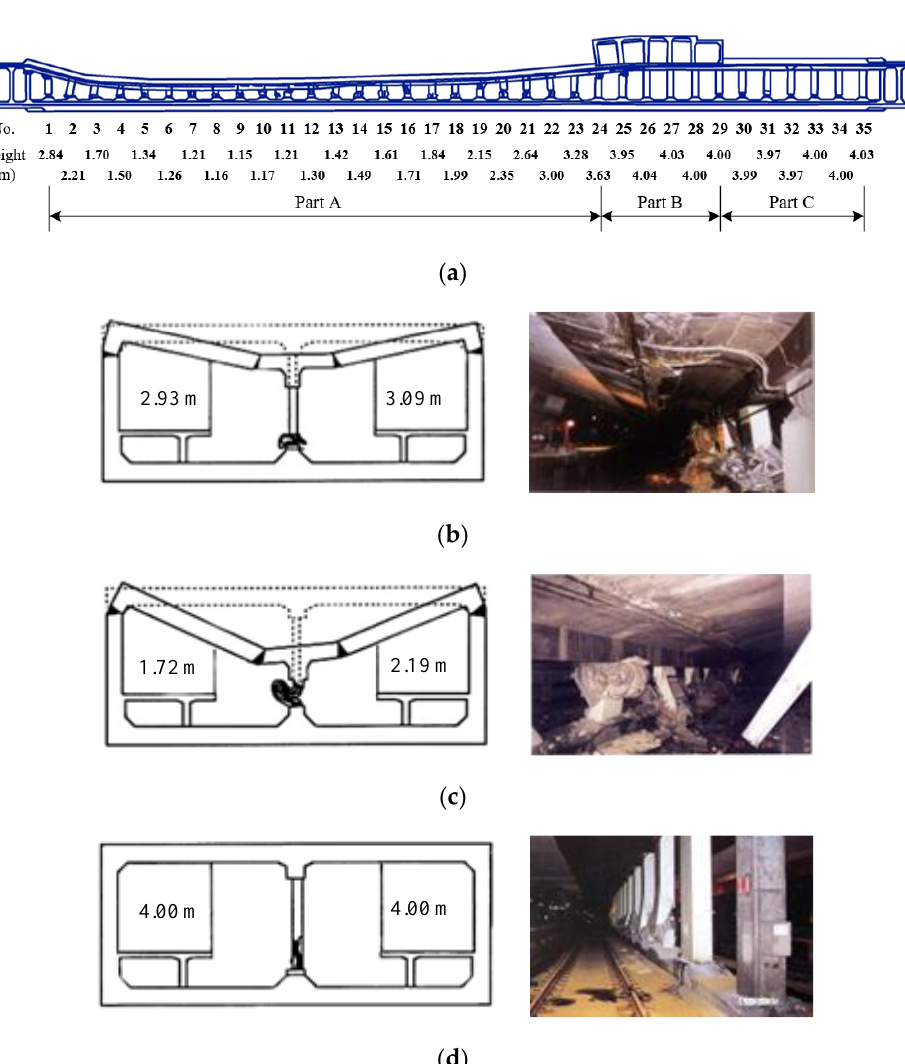
Figure 1. Typical damage patterns in Daikai station: ( a ) Damage of Daikai station; ( b ) Column no. 2; ( c ) Column no. 10; ( d ) Column no. 31.